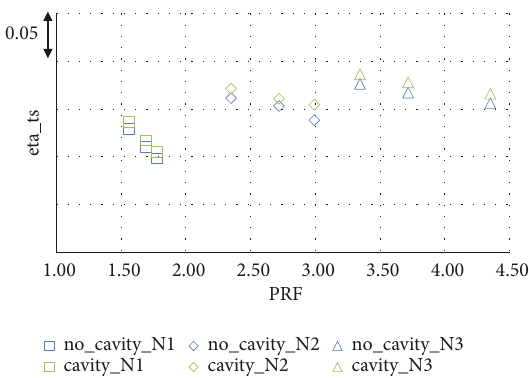
Figure 17: Total-to-static efficiency vs PRF comparison, partial shroud admission.